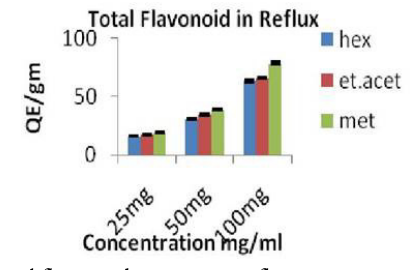
Fig. 8. Total flavonoid content in reflux